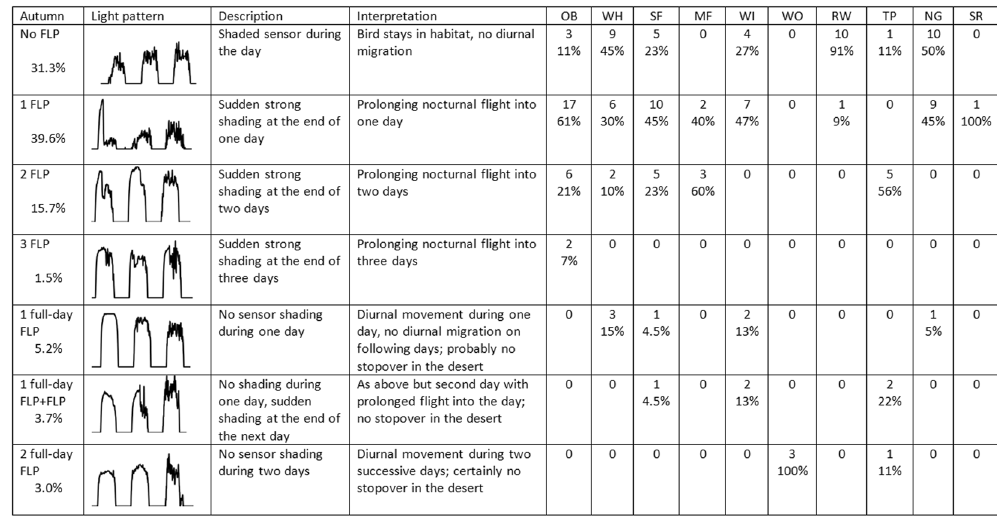
Figure 3. Detailed autumn overview of daytime light pattern anomalies (FLP) recorded by geolocators while birds were crossing a desert. Each category is accompanied by a representative figure of recorded light intensities, description of the anomaly and the most plausible interpretation, numbers of individuals and species-specific % of occurrence, in line with previous publications 9 . OB: ortolan bunting, WH: whinchat, SF: spotted flycatcher, MF: Mediterranean flycatcher, WI: willow warbler, WO: wood warbler, RW: Eurasian reed warbler, TP: tree pipit, NG: nightingale, SR: rufous-tailed scrub-robin. The first four categories total 88.1% of tracked individuals (stopovers in the desert), the last three categories 11.9% (probable non-stop flight over the desert.